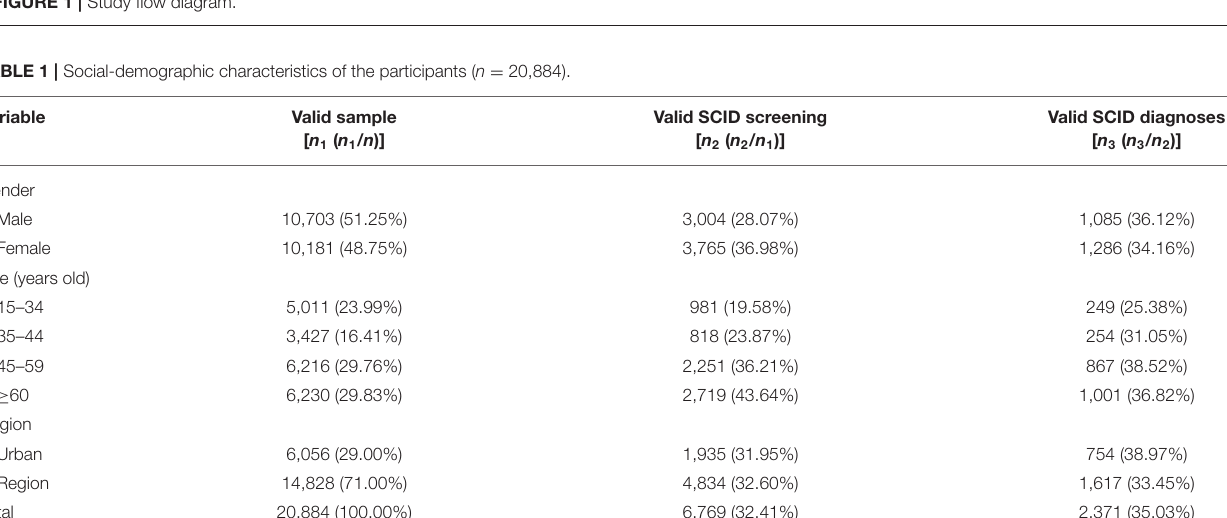
FIGURE 1 | Study flow diagram.